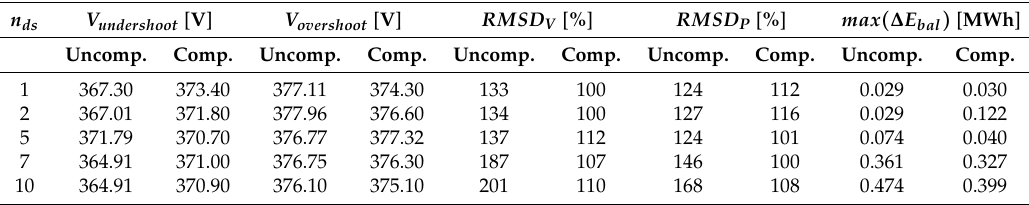
Table 1. Metrics under reduced sampling rates. RMSD V and RMSD p are given relative to the smallest value